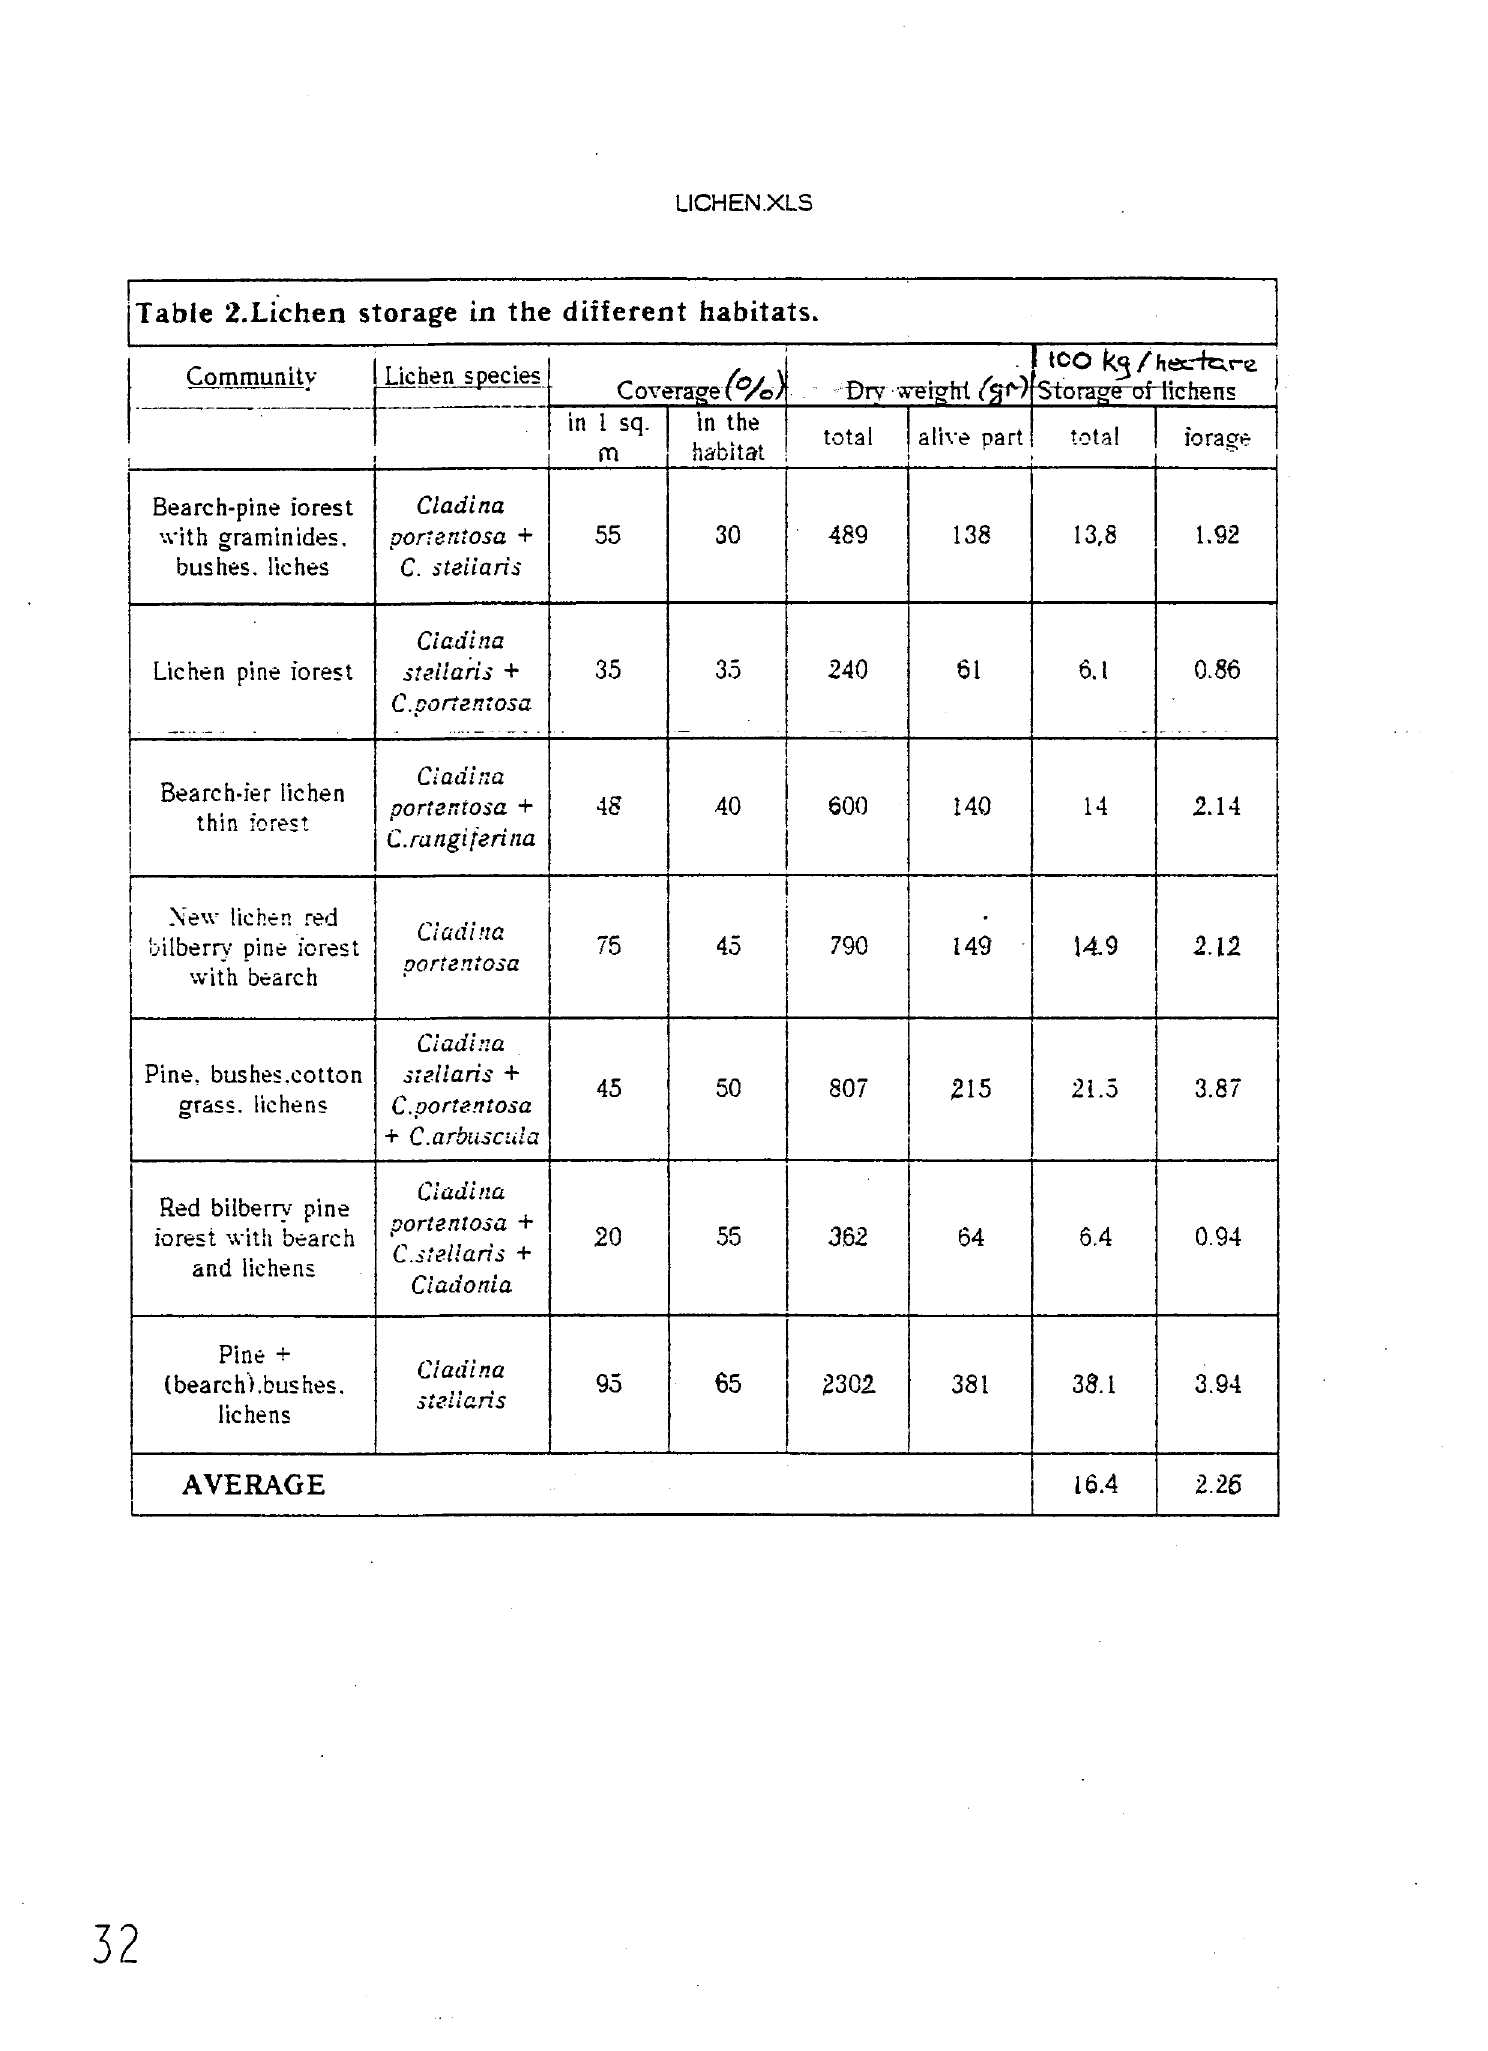
Table 2.Lichen storage in the different habitats. Community Lichen species